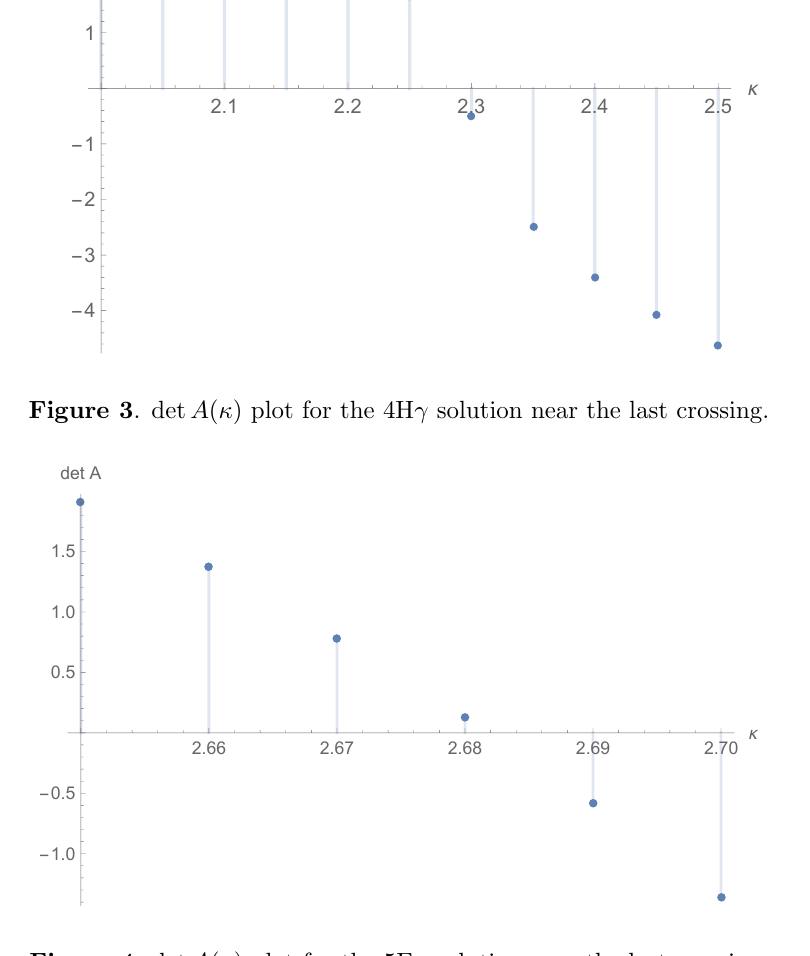
Figure 4 . det A ( (cid:20) ) plot for the 5E (cid:13) solution near the last